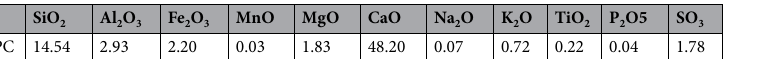
Table 5. Chemical composition [wt%] obtained through X-ray fluorescence analysis for Portland cement Samples. The material used in this study was Portland cement (Cementa, Heidelberg Cement Northern Europe Sweden). The mineral composition determined by XRD-Rietveld analysis is given in Table 4. Samples at different water-to-cement ratios by mass ( w / c = 0.3, 0.4 and 0.5) were prepared using distilled water. To avoid water evaporation and sedimentation during hardening, each sample was casted in a sealed plastic tube (diame- ter 2 cm), which was slowly rotated during 2 days. After 1 week of hydration, circular samples were cut from the hardened material and then stored in plastic bags at room temperature (298 K). The analysis of the samples was done 3 weeks after the preparation casting (OPC-3w) and after four years (OPC-4y). It is important to note that the OPC was maintained in the same preparation container for 4 years at room temperature. Hydration products in the sample aged during 4-years were determined using XRD-Rietveld analysis and the following phases were found: calcite (55.4 wt%), Portlandite (36.6 wt%), AFt (6.6 wt%) whereas AFm was not quantifiable. The oxide contents of the materials (Table 5) were determined by X-ray fluorescence. From these